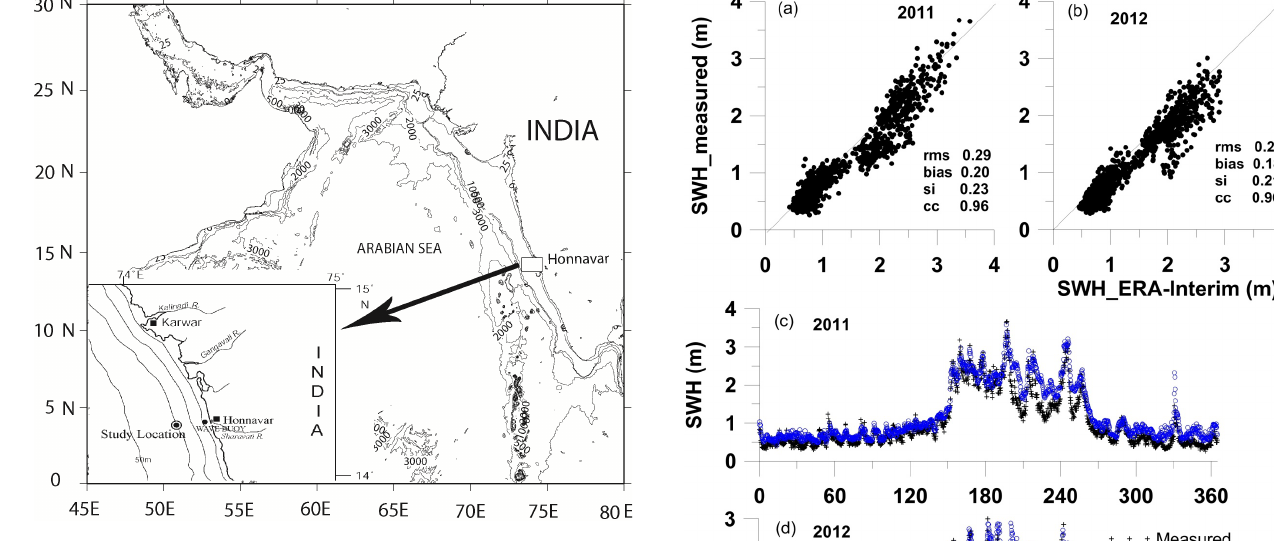
Figure 1. Study area along with location of extracted model data set and buoy.